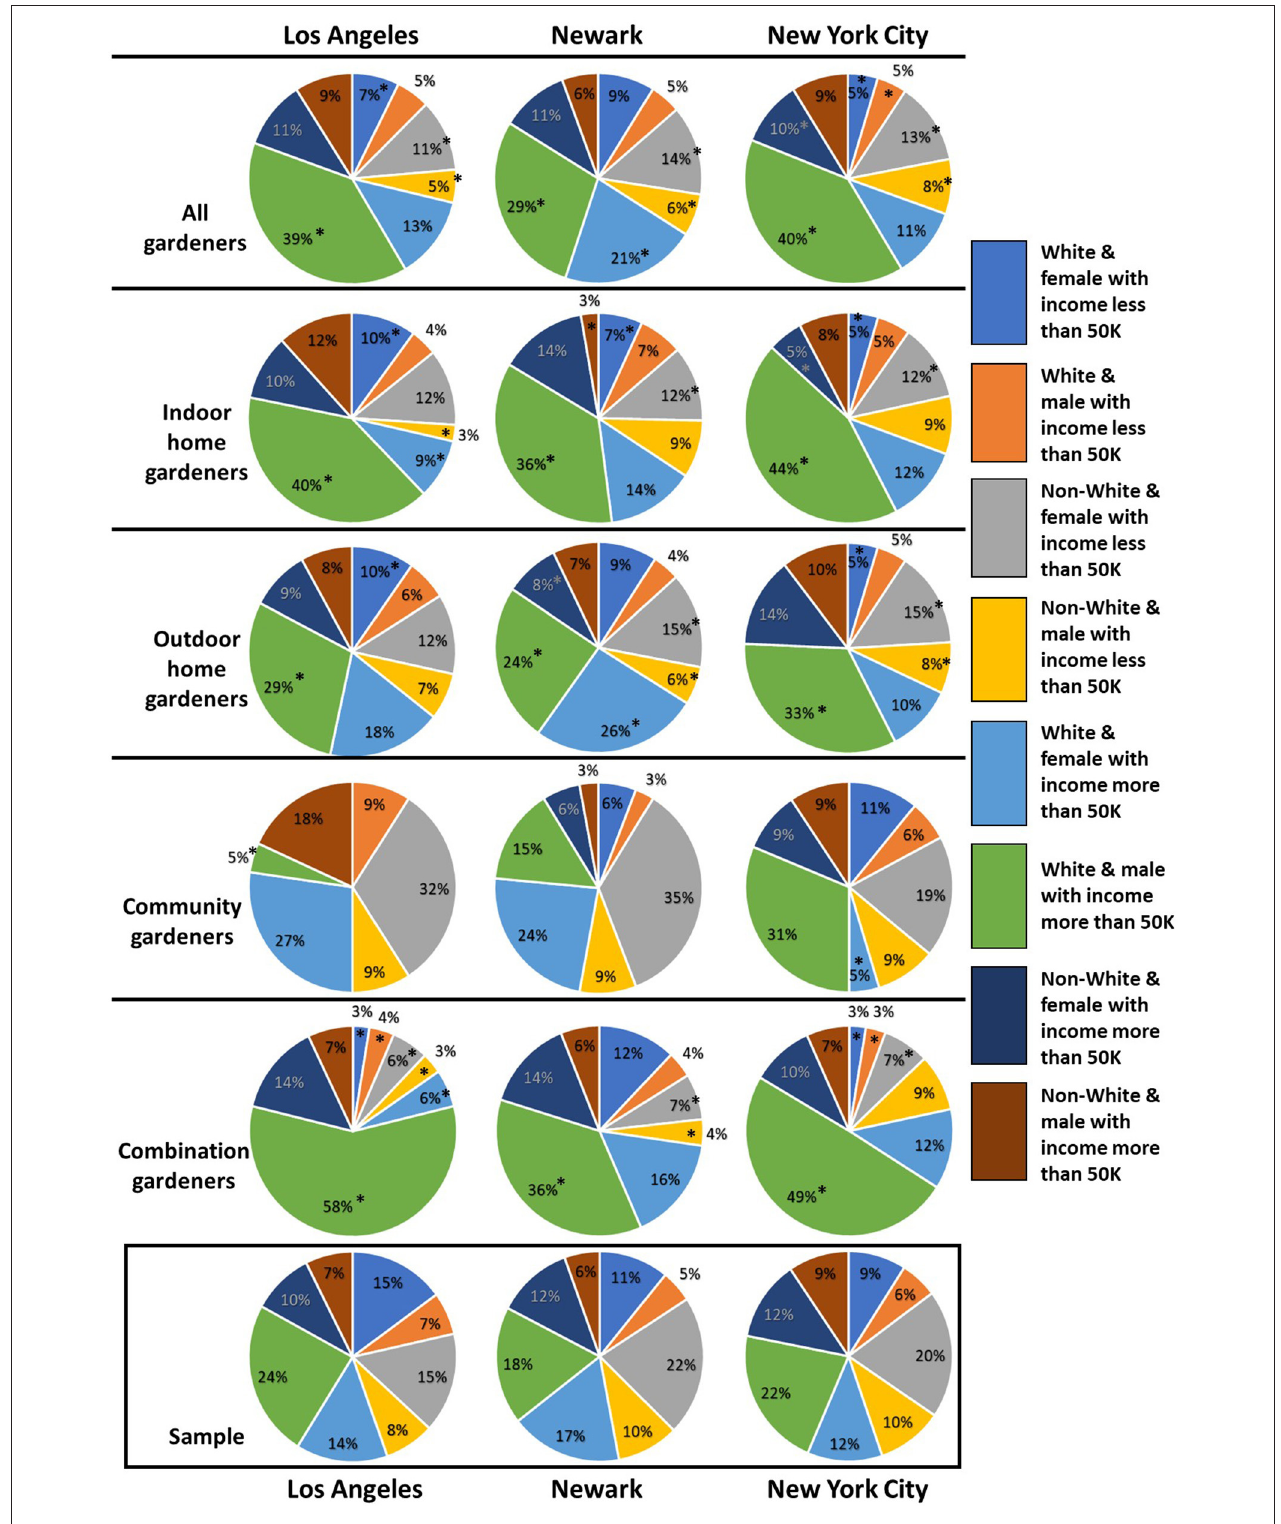
FIGURE 2 | Percentage of agricultural gardeners represented as eight mutually exclusive demographic groups based on race, gender and income. Compares all gardeners, indoor, outdoor, community, and combination gardeners in three cities to the sample. All gardeners include all four mutually exclusive gardening categories (indoor, outdoor, community, and combination gardeners) *statistical significance at 95% CI relative to the survey sample.